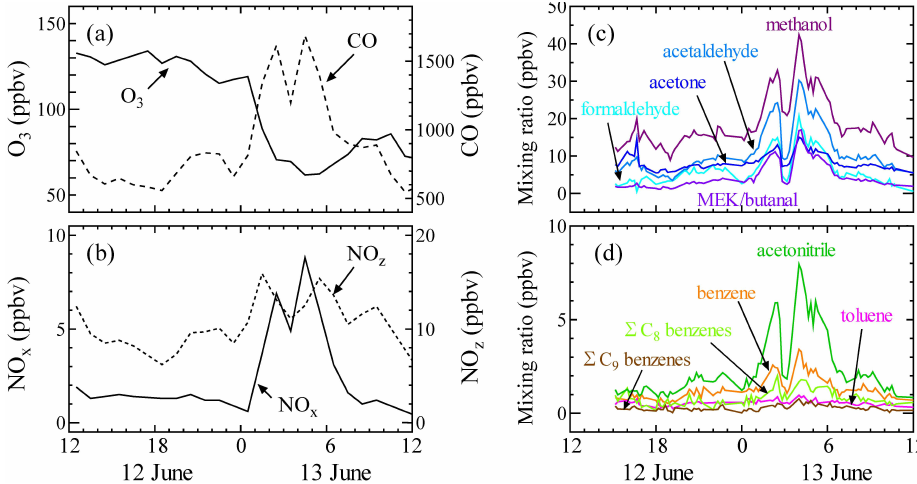
Fig. 8. Temporal variations of mixing ratios of O 3 , CO, NO x , NO z , and several NMVOCs during the night of 12 June. Ten-minute averaged PTR-MS data are shown for the VOCs. Table 5. 1 NMVOCs/ 1 CO (pptv/ppbv) ratios during the biomass burning plume. NMVOC This work a Andreae and Merlet (2001) Karl et al. (2007) b m/z Mount Tai Agricultural residues Fires in tropical forest fuels Acetonitrile 42 4.8 ± 1.1 1.3 2.5 ± 0.8 Formaldehyde 31 11.9 ± 3.0 14 11 ± 10 Acetaldehyde 45 17.6 ± 3.5 4.5 11 ± 7 Methylethylketone 1.9 3.0 ± 2.6 73 9.7 ± 2.4 0.1 2.3 ±